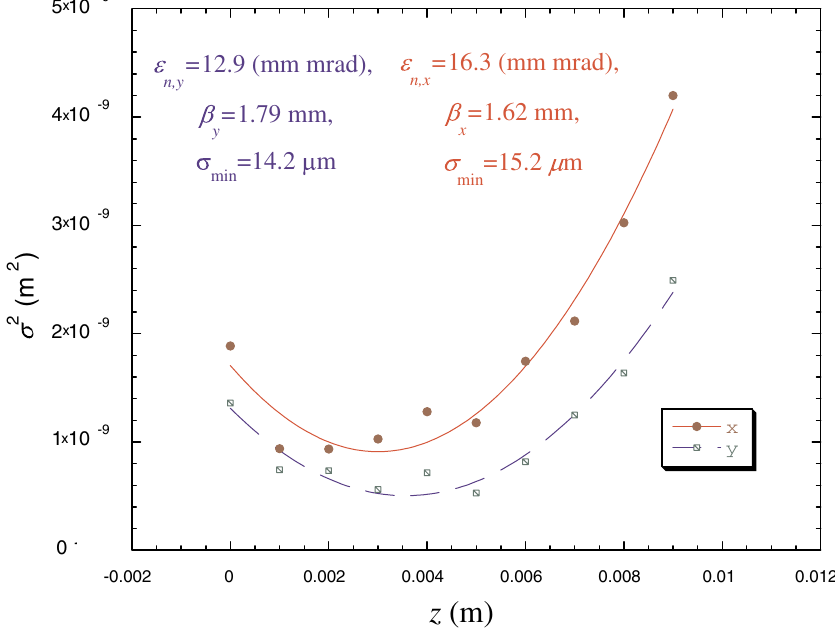
FIG. 22. (Color) Quadrupole scan of the final-focus beam at LLNL PLEIADES, performed by moving the entire PMQ